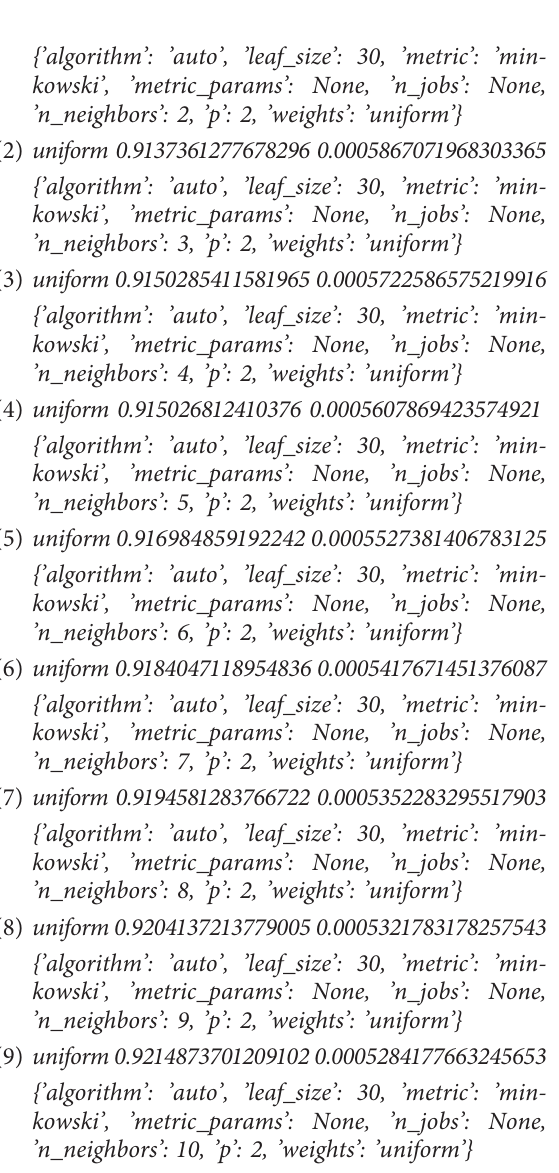
From Figure 11, the difference in the stability of the